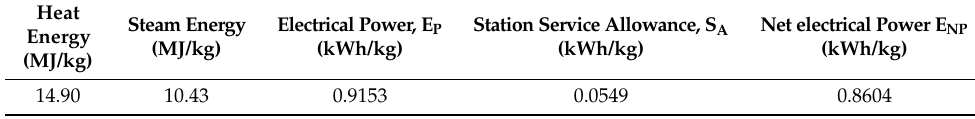
Table 8. Determination of net electrical power from MSW in